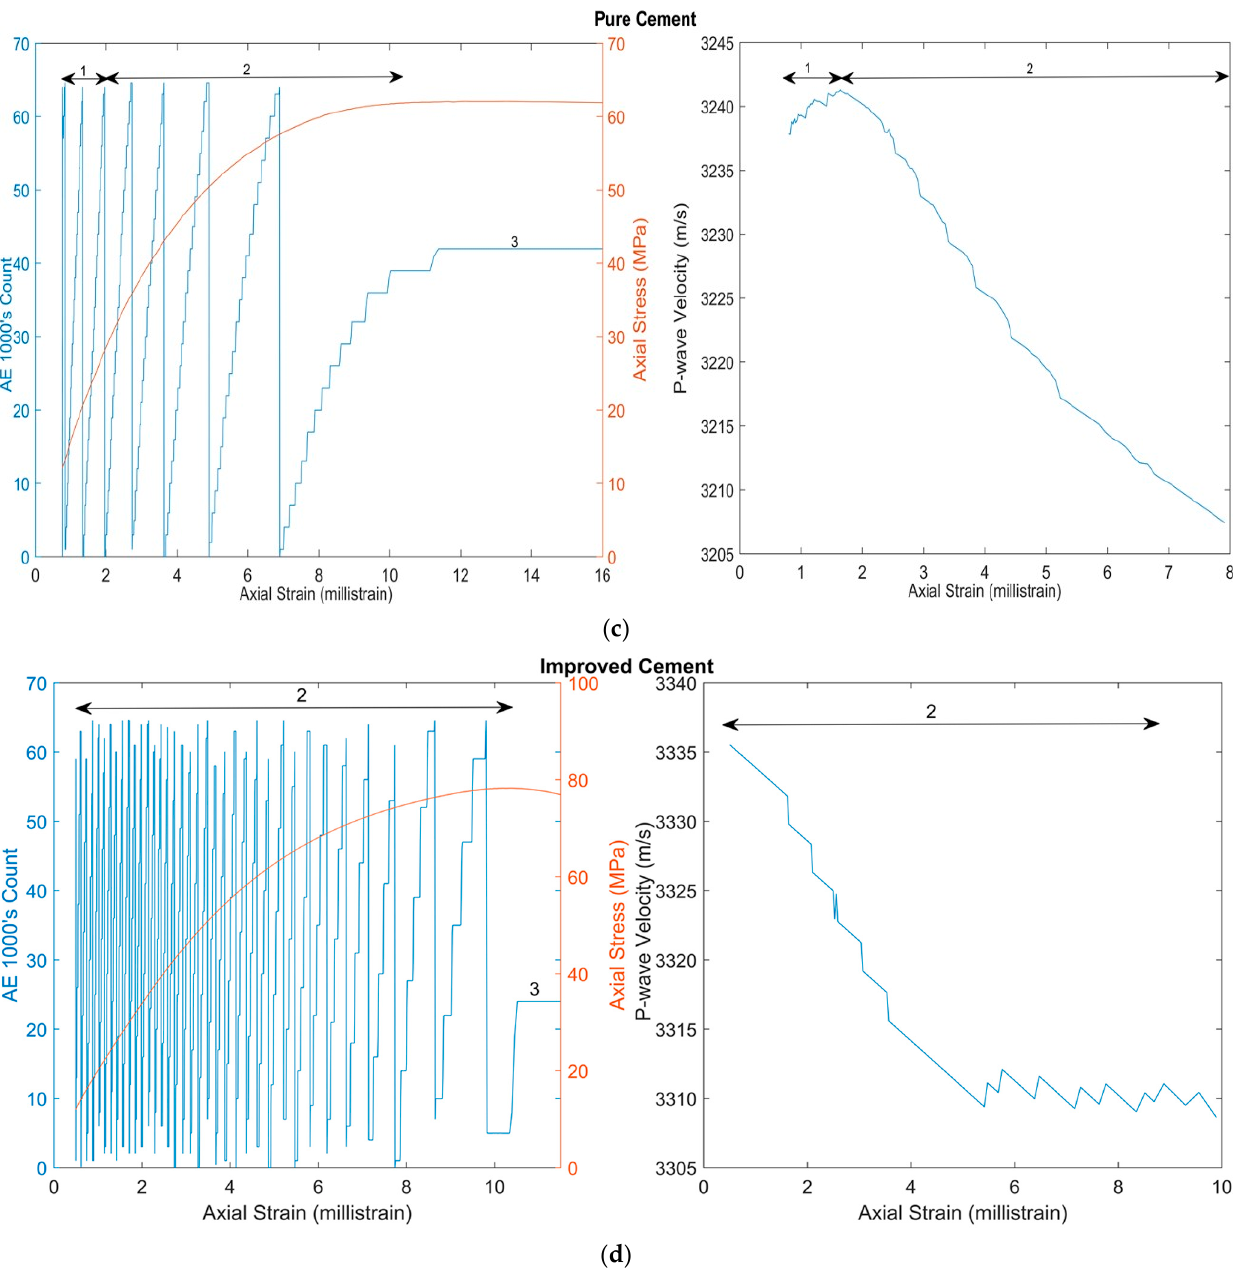
Figure 5. Failure analysis in a whole specimen. Acoustic emission (AE) counts in blue and axial stress in red are shown as a function of axial strain for ( a ) Berea ( b ) Torrey ( c ) pure cement and ( d ) improved cement in the left plots. The plots depict three distinct events: (1) compaction, (2) multi-cracking, and (3) sliding. The right plots show the P-wave velocities as a function of axial strain.